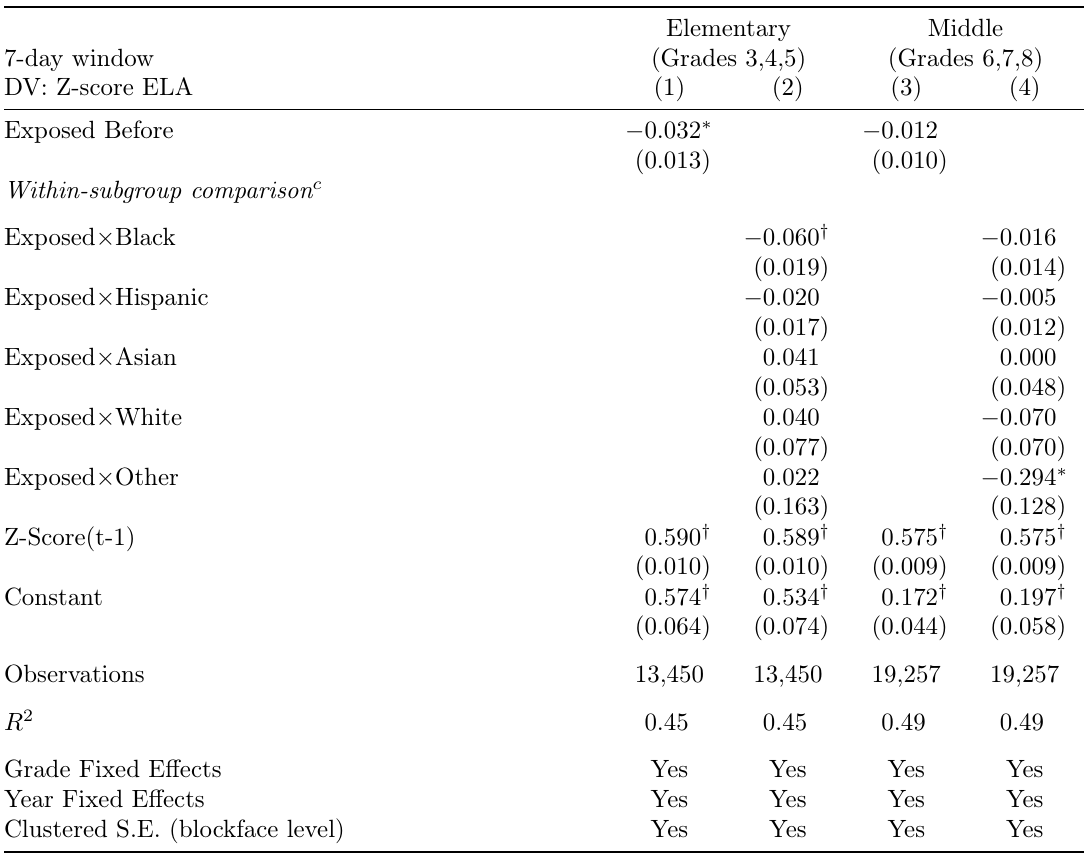
Table 5: Grade Models (School Years 2004/2005 to 2009/2010): Impact of Exposure to Violent Crime a and in a High-Poverty Sample